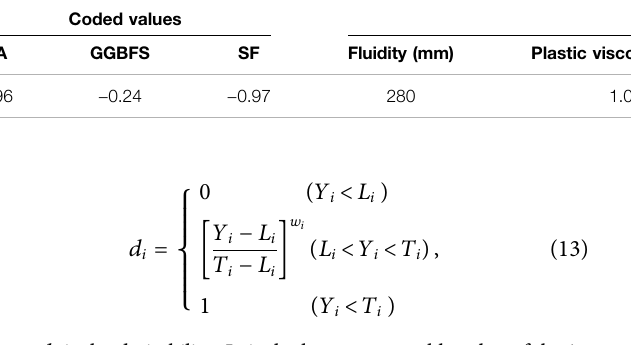
TABLE 6 | The results of multi-objective optimization of nano-silica modi fi ed cement-based paste containing SCMs. Coded